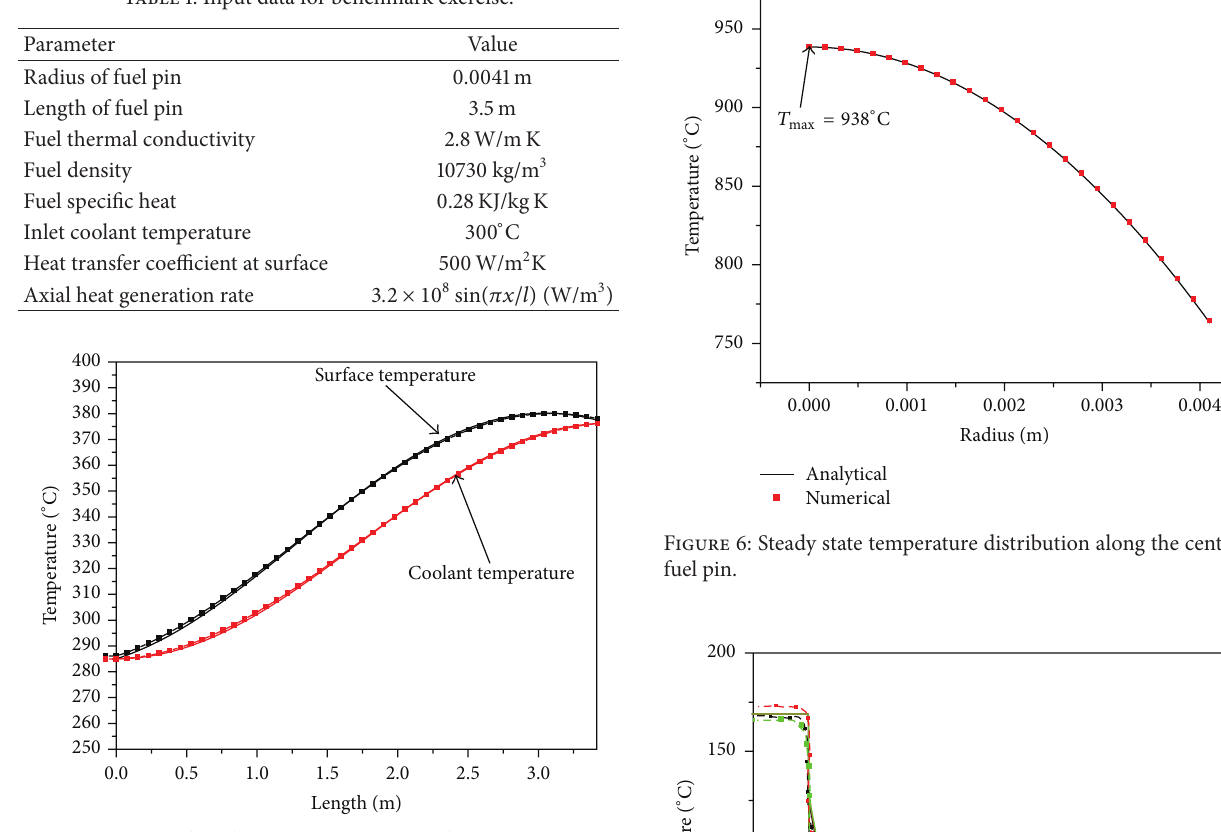
Table 1: Input data for benchmark exercise.